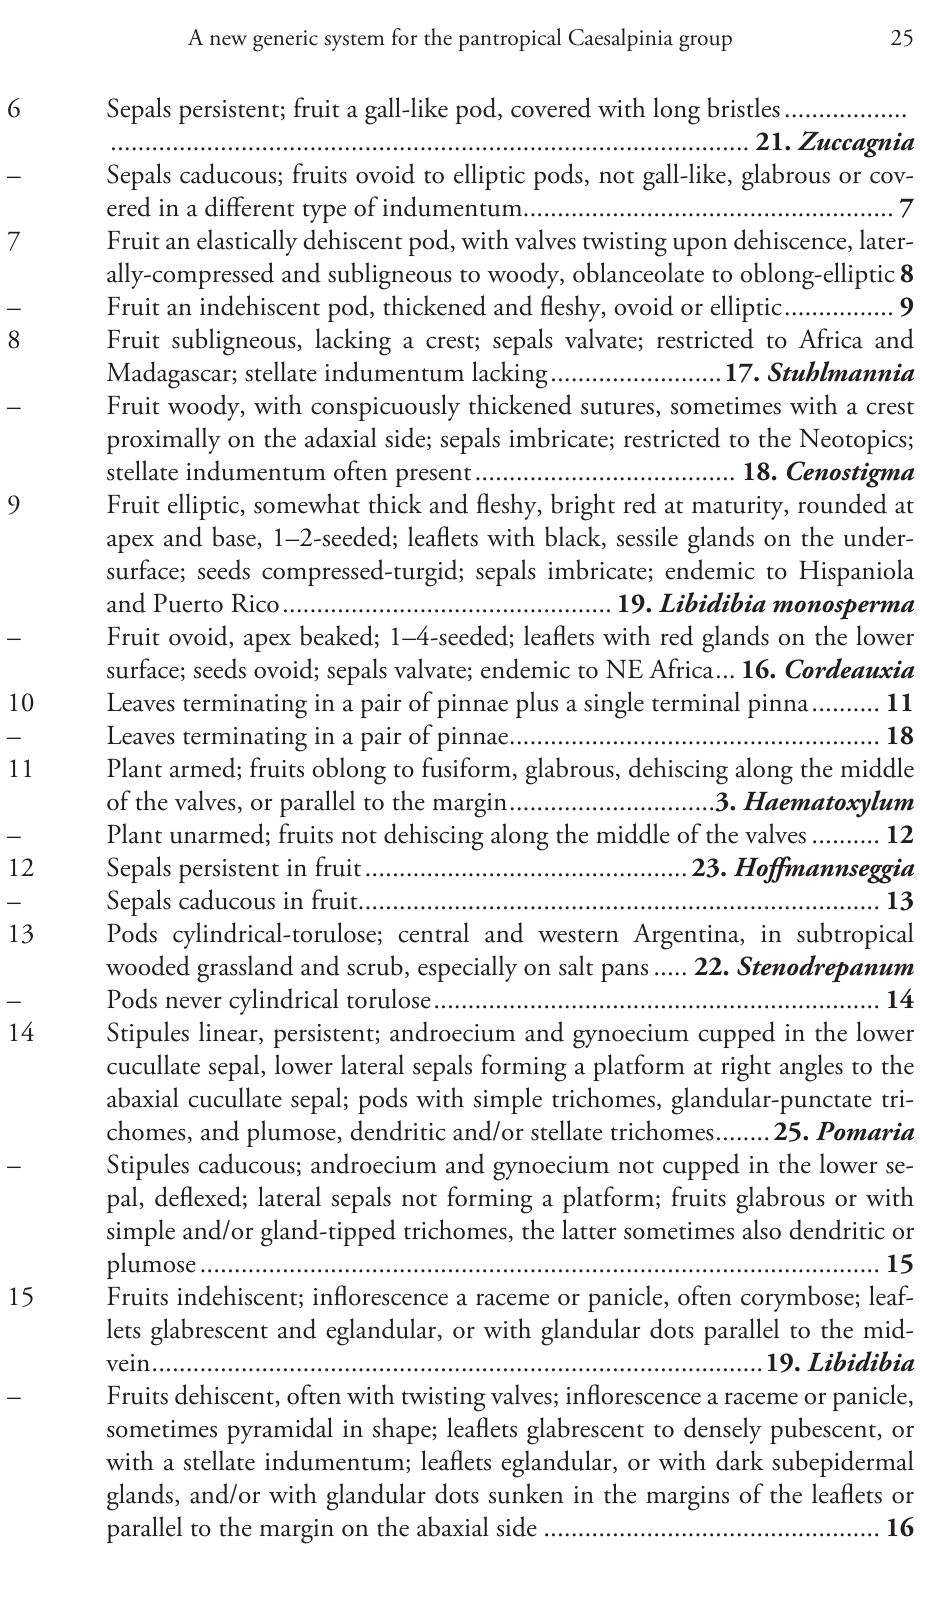
– Sepals caducous; fruits ovoid to elliptic pods, not gall-like, glabrous or cov- 7 Fruit an elastically dehiscent pod, with valves twisting upon dehiscence, later- ally-compressed and subligneous to woody, oblanceolate to oblong-elliptic 8 – Fruit an indehiscent pod, thickened and fleshy, ovoid or elliptic ................ 9 8 Fruit subligneous, lacking a crest; sepals valvate; restricted to Africa and Madagascar; stellate indumentum lacking ......................... 17. Stuhlmannia – Fruit woody, with conspicuously thickened sutures, sometimes with a crest proximally on the adaxial side; sepals imbricate; restricted to the Neotopics; stellate indumentum often present ...................................... 18. Cenostigma 9 Fruit elliptic, somewhat thick and fleshy, bright red at maturity, rounded at apex and base, 1–2-seeded; leaflets with black, sessile glands on the under- surface; seeds compressed-turgid; sepals imbricate; endemic to Hispaniola and Puerto Rico ................................................ 19. Libidibia monosperma – Fruit ovoid, apex beaked; 1–4-seeded; leaflets with red glands on the lower surface; seeds ovoid; sepals valvate; endemic to NE Africa ... 16. Cordeauxia 10 Leaves terminating in a pair of pinnae plus a single terminal pinna .......... 11 – Leaves terminating in a pair of pinnae ...................................................... 18 11 Plant armed; fruits oblong to fusiform, glabrous, dehiscing along the middle of the valves, or parallel to the margin .............................. 3. Haematoxylum – Plant unarmed; fruits not dehiscing along the middle of the valves .......... 12 12 – 13 Pods cylindrical-torulose; central and western Argentina, in subtropical wooded grassland and scrub, especially on salt pans ..... 22. Stenodrepanum – Pods never cylindrical torulose ................................................................. 14 14 Stipules linear, persistent; androecium and gynoecium cupped in the lower cucullate sepal, lower lateral sepals forming a platform at right angles to the abaxial cucullate sepal; pods with simple trichomes, glandular-punctate tri- chomes, and plumose, dendritic and/or stellate trichomes ........ 25. Pomaria – Stipules caducous; androecium and gynoecium not cupped in the lower se- pal, deflexed; lateral sepals not forming a platform; fruits glabrous or with simple and/or gland-tipped trichomes, the latter sometimes also dendritic or 15 Fruits indehiscent; inflorescence a raceme or panicle, often corymbose; leaf- lets glabrescent and eglandular, or with glandular dots parallel to the mid- – Fruits dehiscent, often with twisting valves; inflorescence a raceme or panicle, sometimes pyramidal in shape; leaflets glabrescent to densely pubescent, or with a stellate indumentum; leaflets eglandular, or with dark subepidermal glands, and/or with glandular dots sunken in the margins of the leaflets